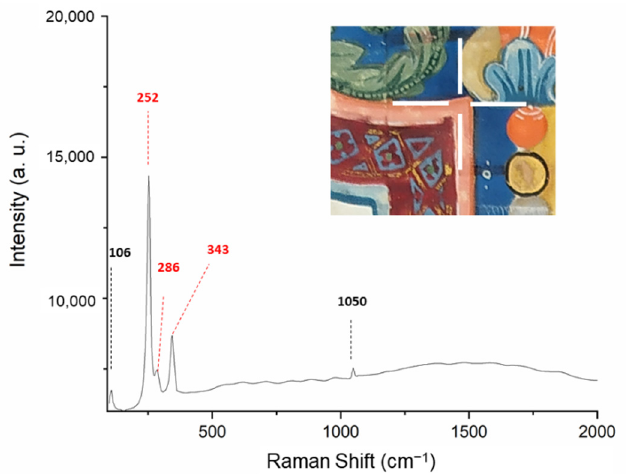
Figure 9. Raman spectra of the red frame of the initial “P” (displayed inside the white cross). The peaks of lead white are reported in black colour, those of vermillion are indicated with a red colour.